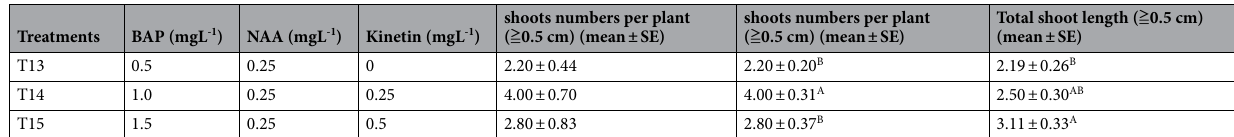
Table 4. The influence of different concentrations of plant growth regulators on bud proliferation of S. costus . vigorous and green buds (+ + +); healthy buds (+ +); weak buds ( +). Each value represents the mean ± SE of five